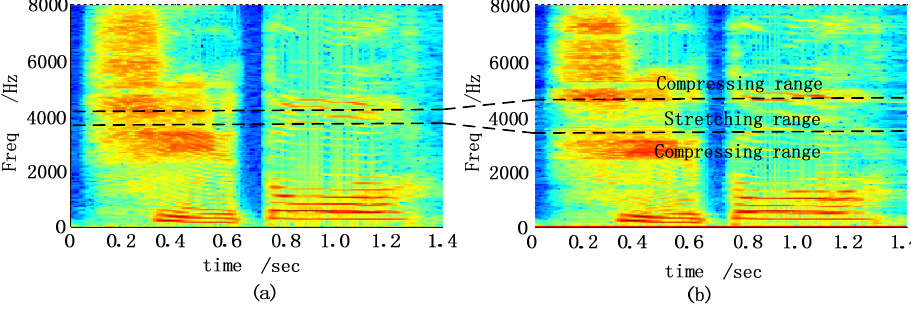
Figure 5. Spectrograms of a Chinese disyllabic word. ( a ) Spectrogram before process; ( b ) Spectrogram after process.